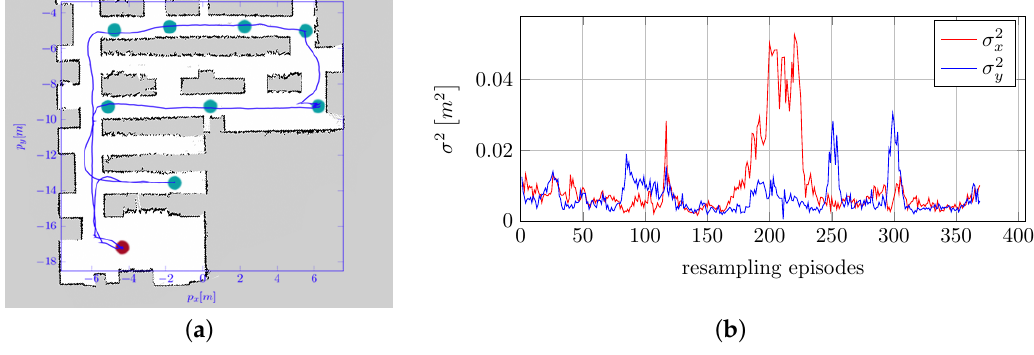
Figure 9. Localization and path planning performances. ( a ) Trajectory followed by the robot, as estimated by localization, is shown in blue; ( b ) estimated position error